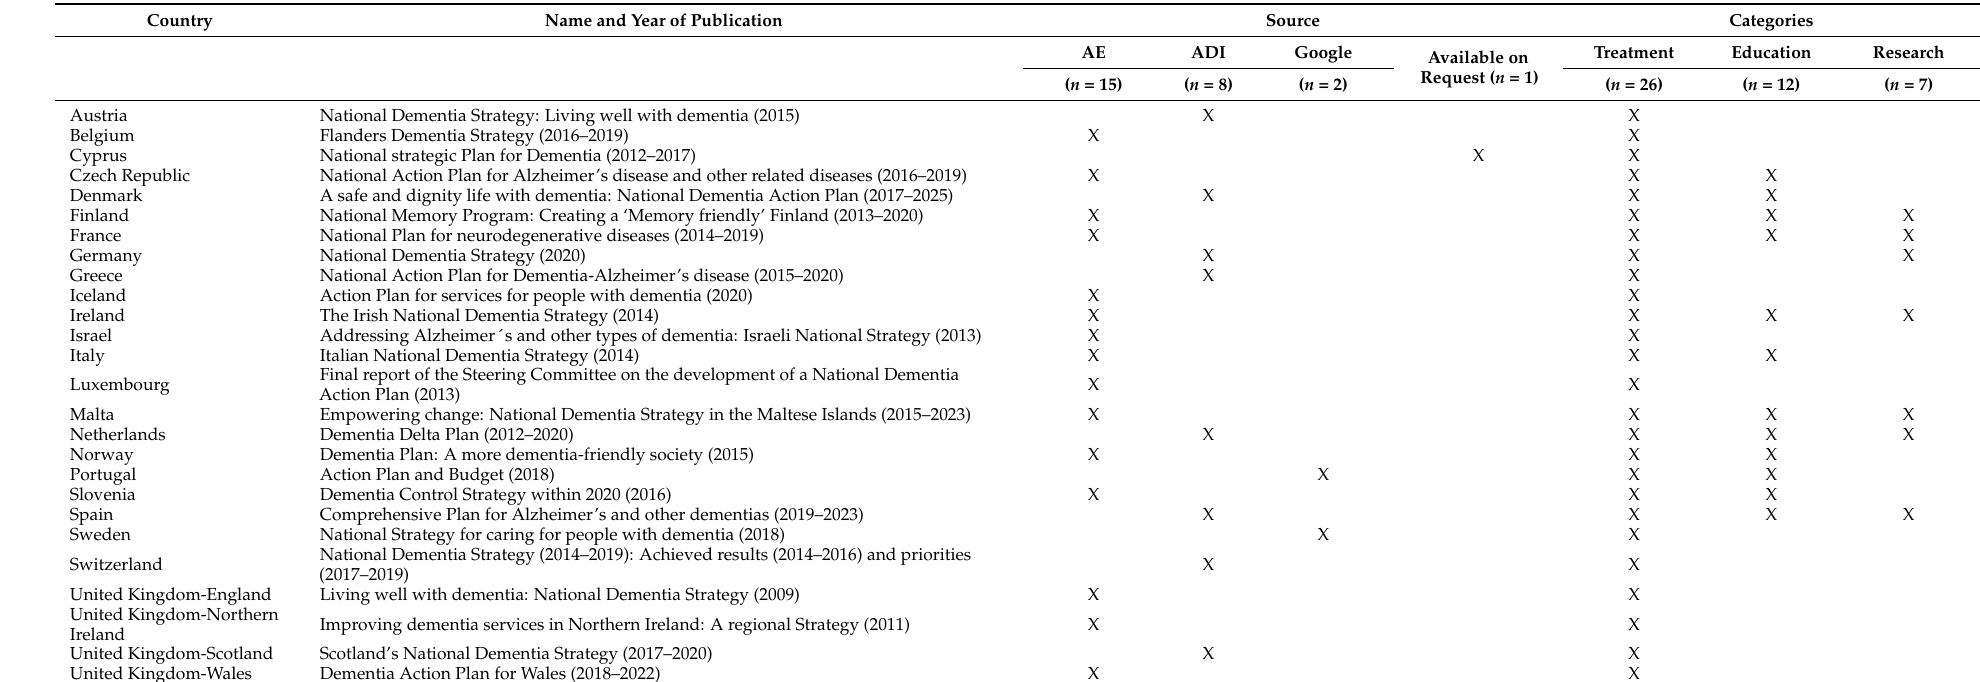
Table 2. Overview of National Dementia Plans and Strategies across